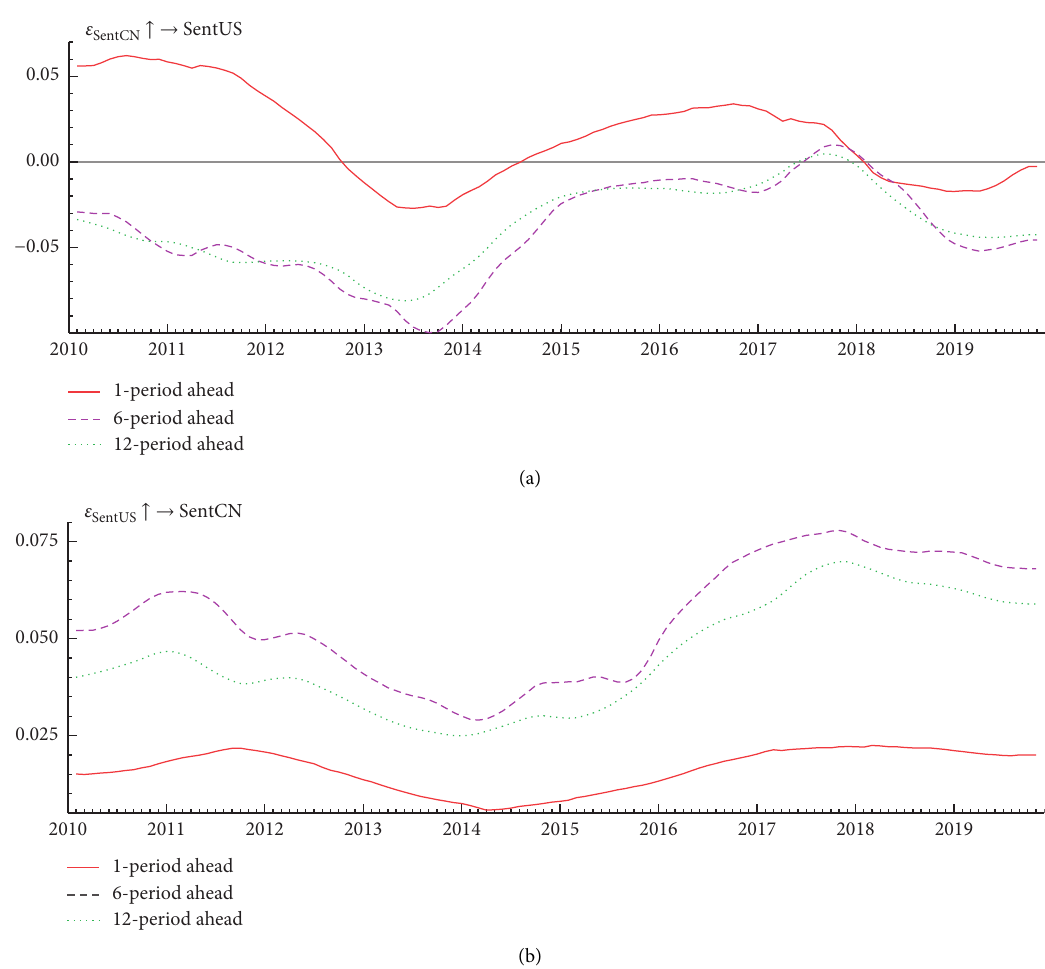
Figure 8: Time-varying impulse responses of China and the US investor